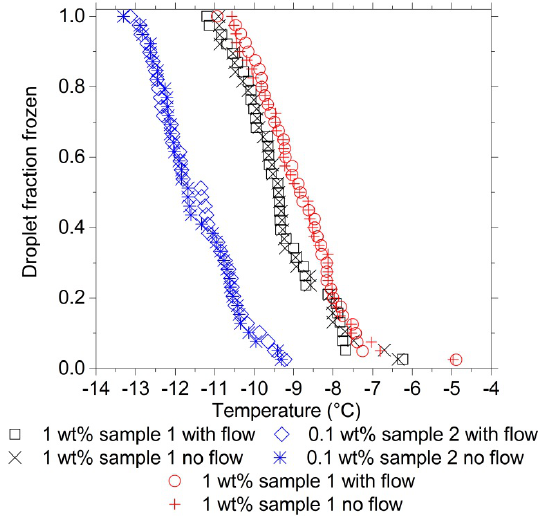
Figure 5. Temperature against droplet fraction frozen with and without dry gas flowing over them. Four different sets of droplets containing K-feldspar were used. It can be seen that switching the dry flow on or off made no systematic difference to freezing tem-